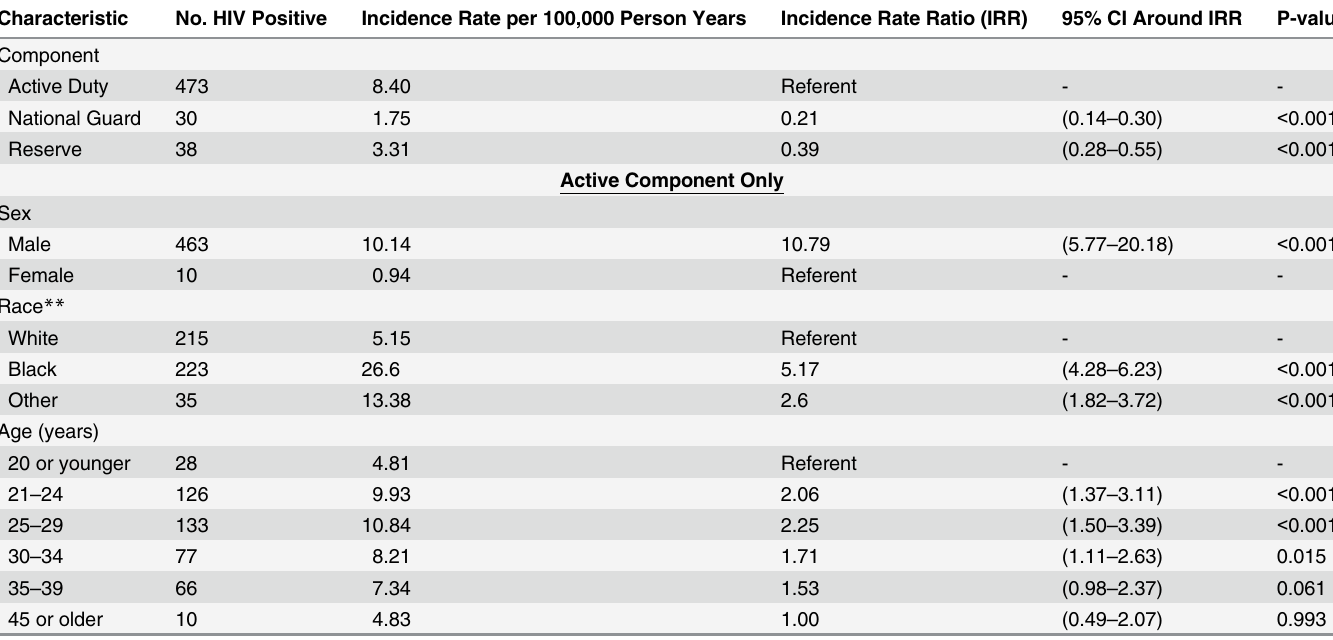
Table 1. Frequencies and incidence rates of HIV among United States Air Force personnel in service at any time from 1996 through 2011 * .